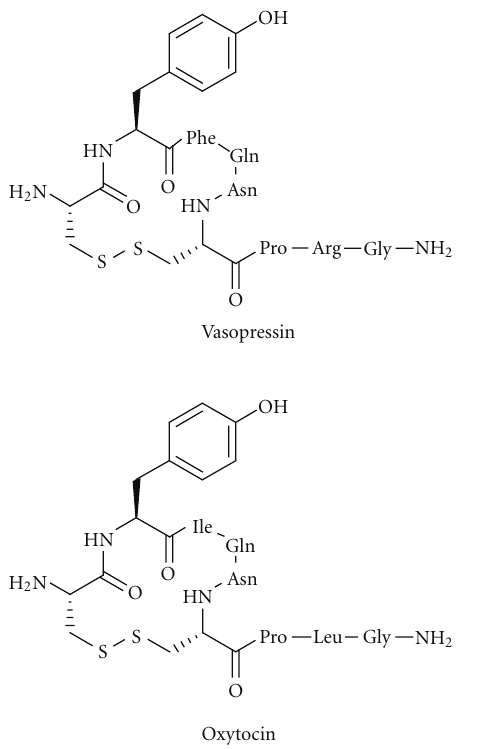
Figure 12: The macrocyclic disulfides vasopressin and oxytocin are substrates of IRAP.